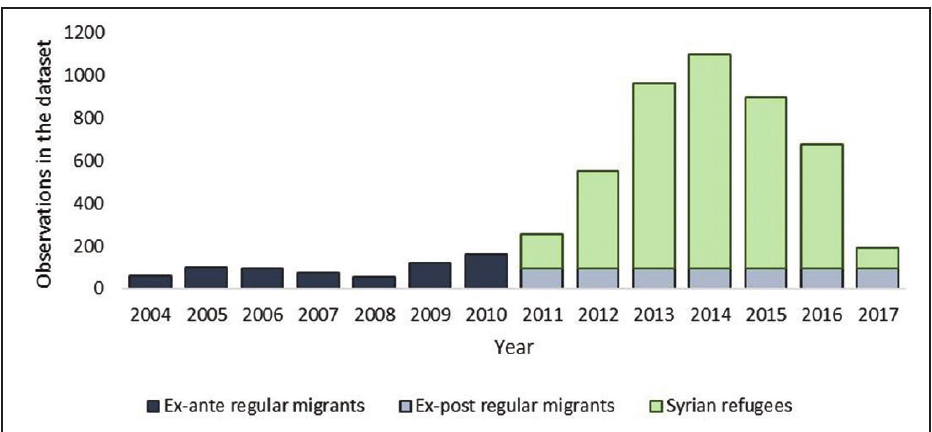
Number of foreign-born individuals in Turkey by the year of arrival,